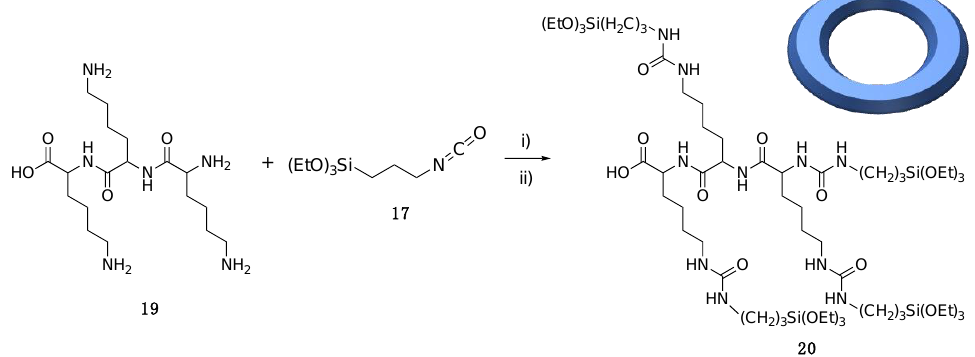
Scheme 7. Schematic representation of the synthesis of tri- L -lysine 19 doped silica nanodonuts [42]. Reaction conditions: (i) NEt 3 , DMF, r.t. 30 min.; (ii) CTAB, NH 4 OH, H 2 O, 50 °C, 2 h.